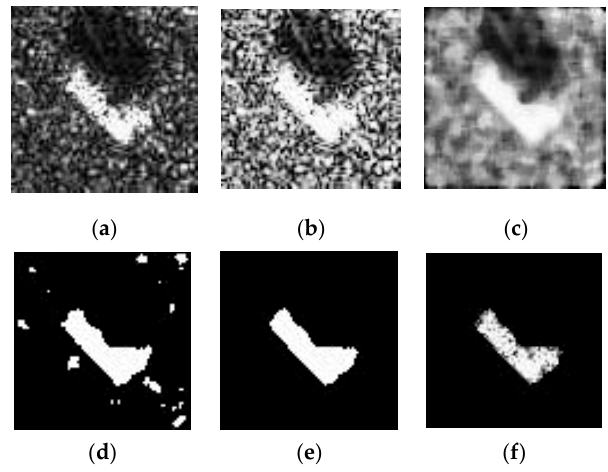
Figure 8. SAR image segmentation process: ( a ) original image, ( b ) equilibrium normalization, ( c ) medium filtering, ( d ) threshold segmentation, ( e ) morphological filtering, and ( f ) image after segmentation.